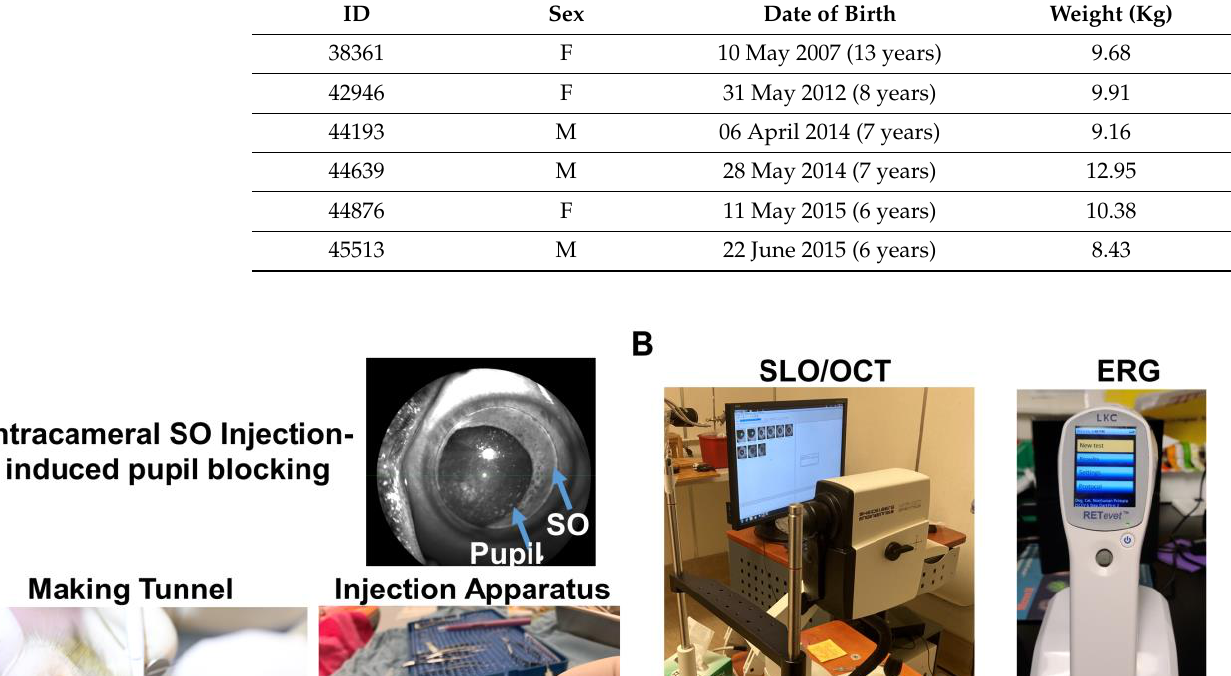
Table 1. Animal Information.